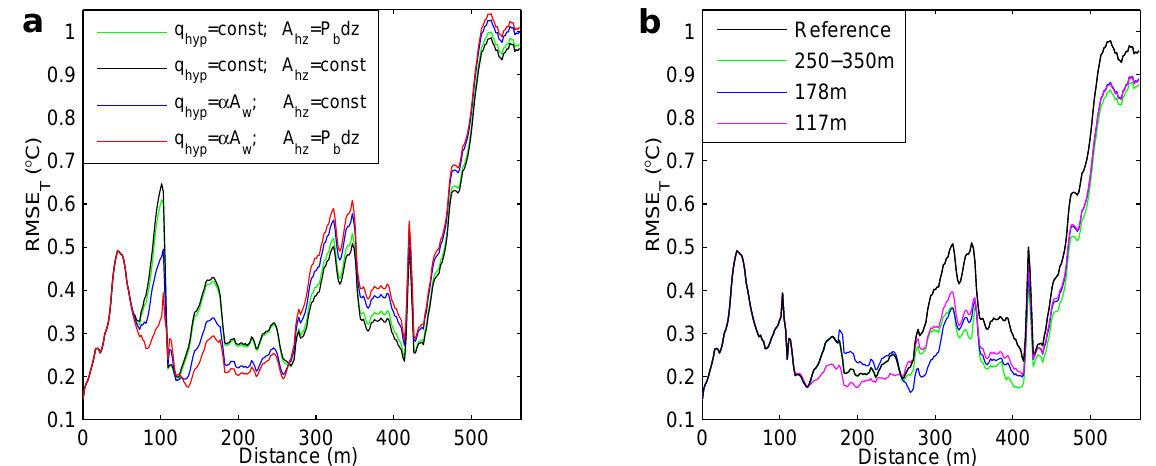
Fig. 6. RMSE T for (a) different hyporheic exchange scenarios, and (b) different locations of the new source. Reference refers to the simulation where q hyp and A hz are variable between 0 and 250m and constant between 250 and 564m, but without the new source. The numbers of the other solutions are the location of the new source. A moving average of 3 observation point in space was taken for all time series between 23 June 2008, 01:00 and 10:00h GMT+1.